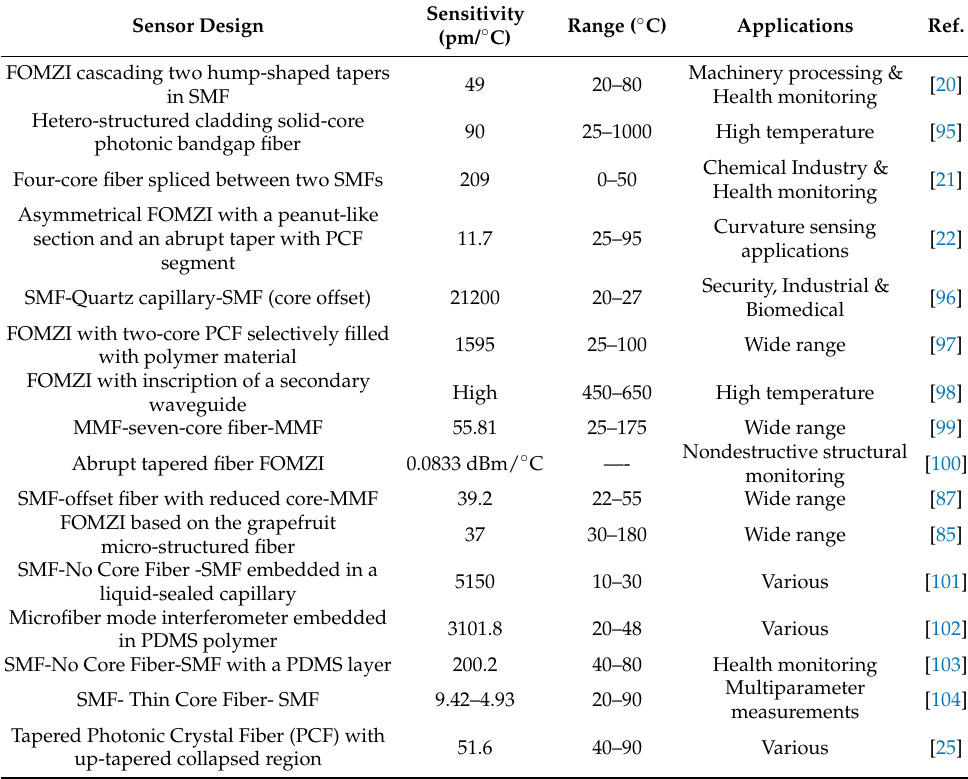
Table 4. Temperature sensitivity of FOMZI.